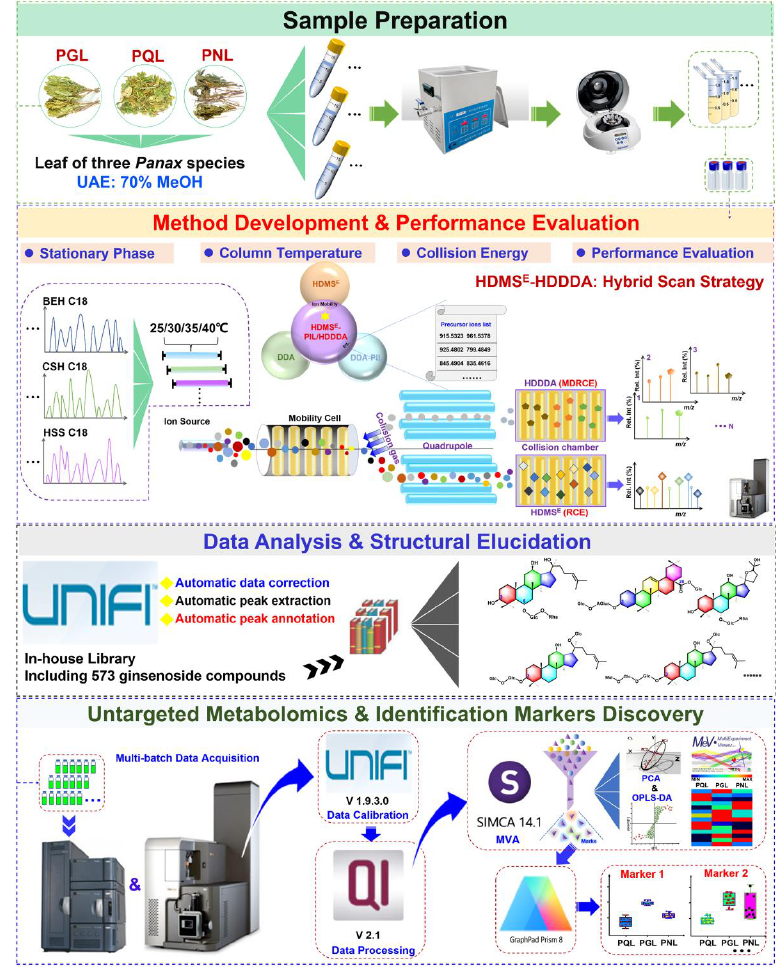
Figure 1. A general technical roadmap of the proposed analytical strategy, by integrating a hybrid scan approach (HDMS E -HDDDA), intelligent data processing workflows facilitated by UNIFI and an in-house ginsenoside library, and untargeted metabolomics, for the holistic comparison of gin- senosides from the leaves of three Panax species ( P. ginseng , P. quinquefolius , and P. notoginseng ).